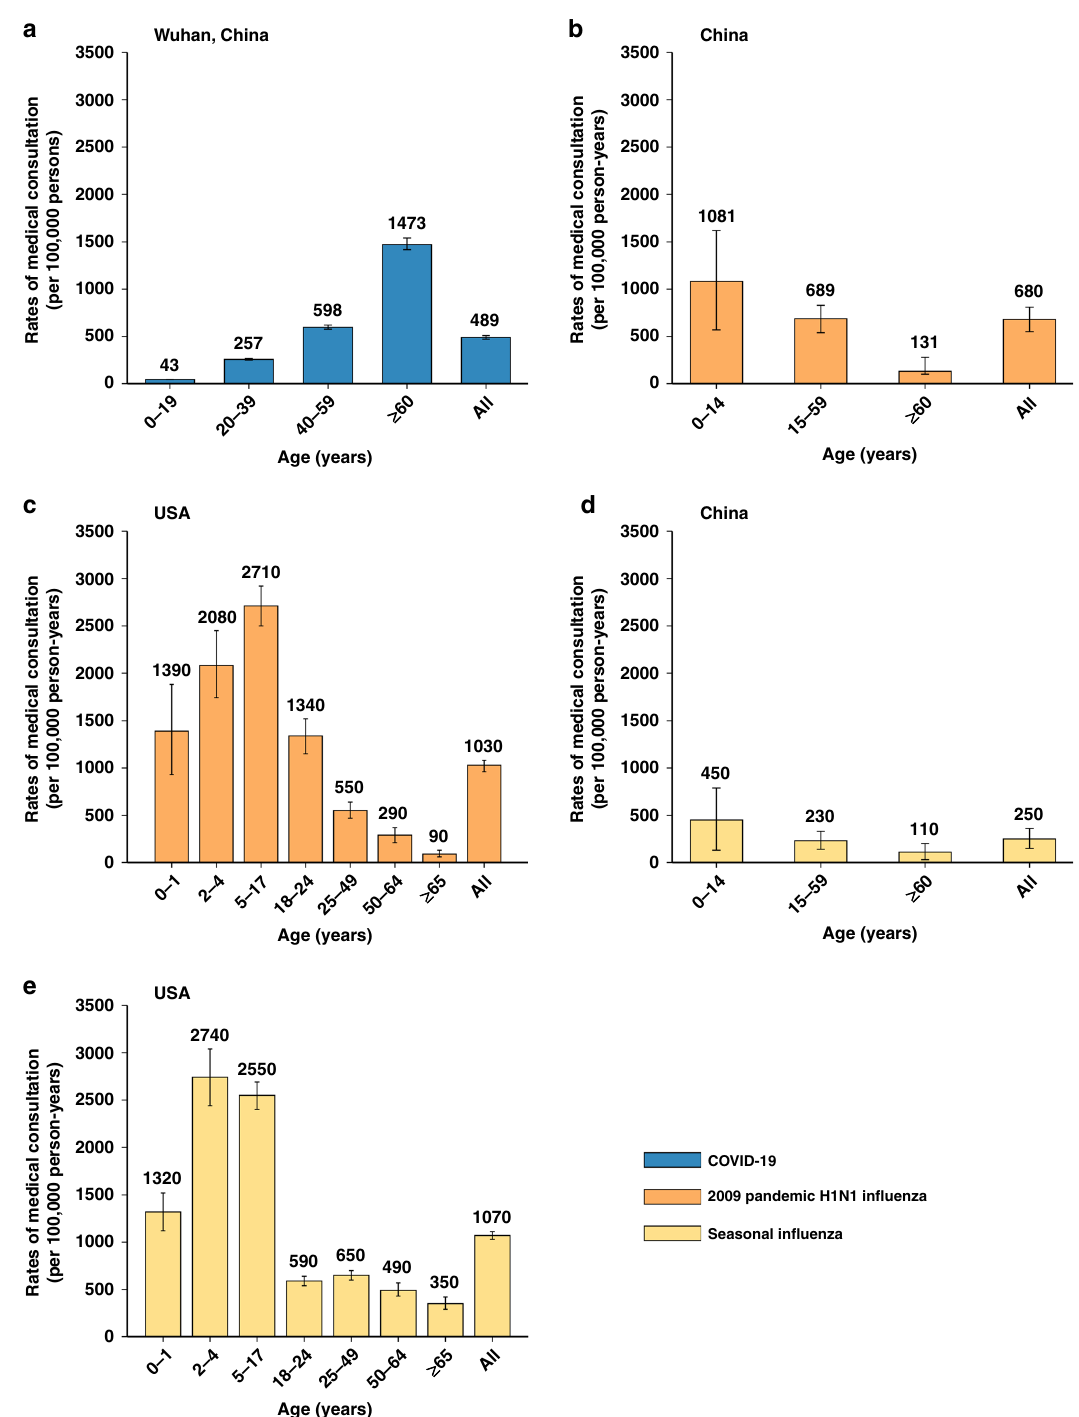
Fig. 2 Rates of symptomatic cases and of medical consultation rates by age group (mean, 95% CI). a Rates of medical consultation associated with COVID-19 in Wuhan, China. The error bars presented 95% CI as estimated using Monte Carlo sampling (10,000 samples from Binomial distributions). b Rates of medical consultation associated with 2009 pandemic H1N1 in fl uenza, China 14 . c Rates of medical consultation associated with 2009 pandemic H1N1 in fl uenza, USA 15 . d Seasonal in fl uenza-associated excess ILI outpatient consultations rates, China 14 . e Rates of medical consultation associated with seasonal in fl uenza, USA 15